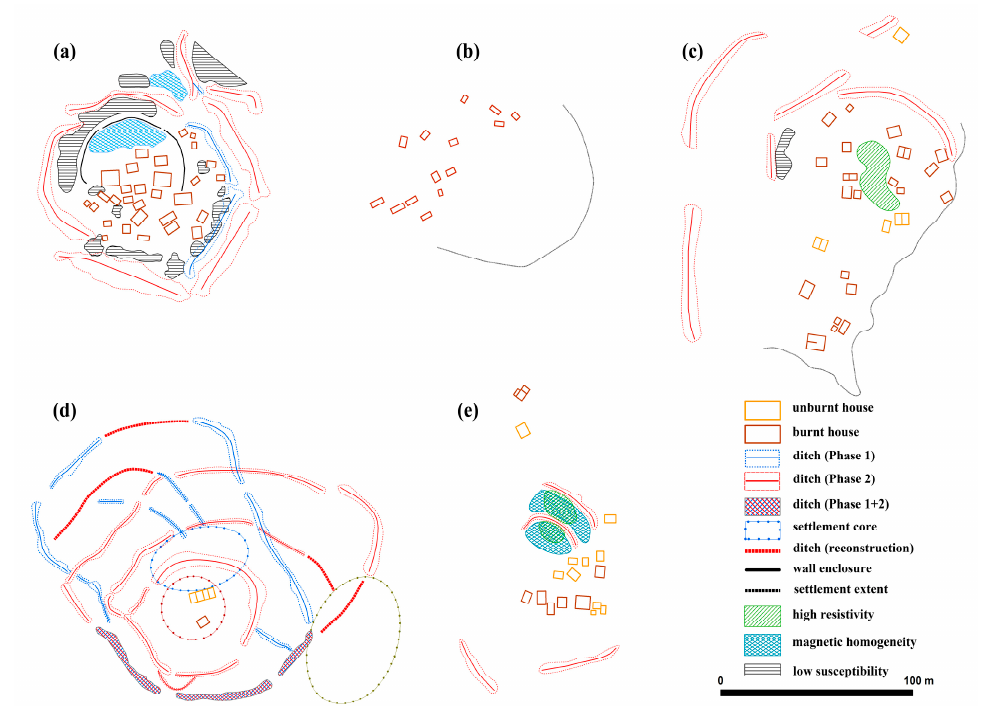
Figure 24. Proposed settlement layout reconstructions from: ( a ) Almyros 2; ( b ) Kamara; ( c ) Karatsantagli; ( d ) Perdika 2; and ( e ) Perivlepto/Kastraki 2. These vector data can also be viewed with the help of an online GIS served at